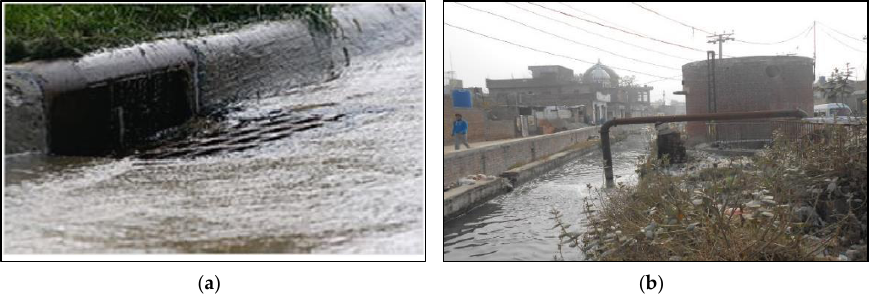
Figure 1. ( a ) Urban runoff flowing into the sewer drain; ( b ) sewage outfall into the Charar drain